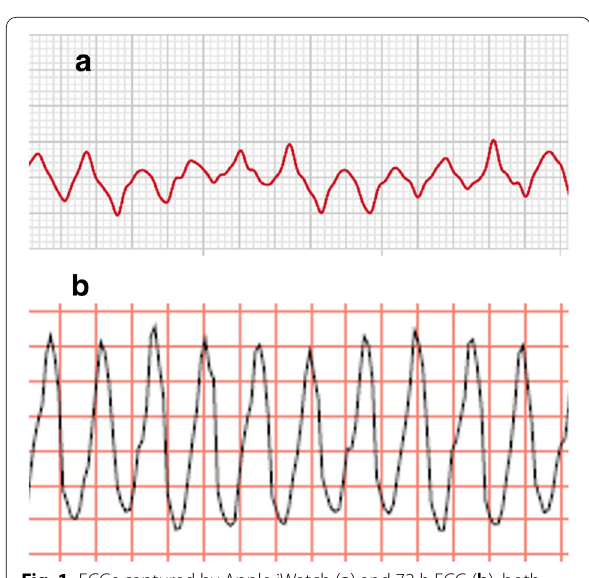
Fig. 1 ECGs captured by Apple iWatch ( a ) and 72 h ECG ( b ), both demonstrating a broad complex monomorphic tachycardia. Both strips are 25 mm/s, 10 mm/mV, and lead